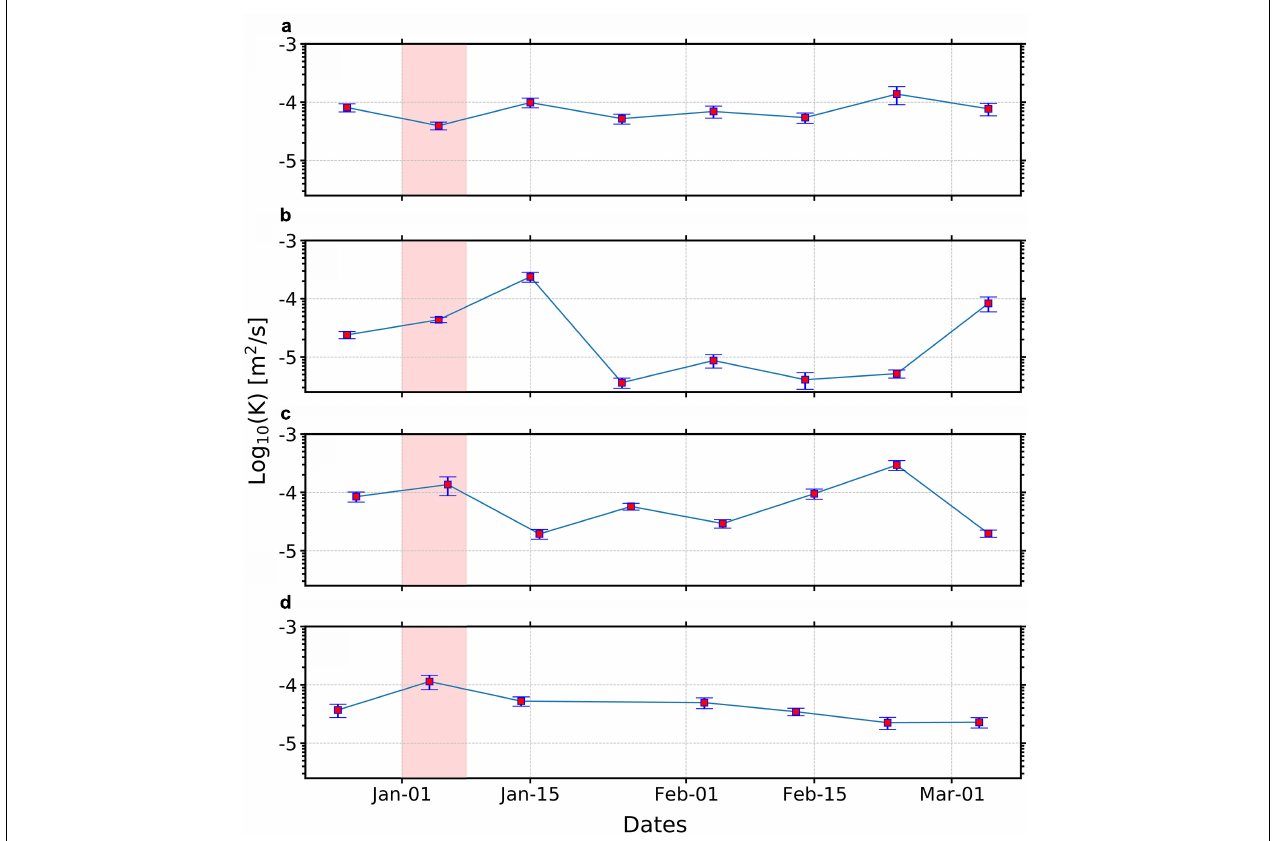
FIGURE 9 | Depth (300–600 m) averaged diffusivity from Argo floats (a–d) as a function of time during and after the storm. Vertical red bands mark the time of the storm. Error bars represent standard